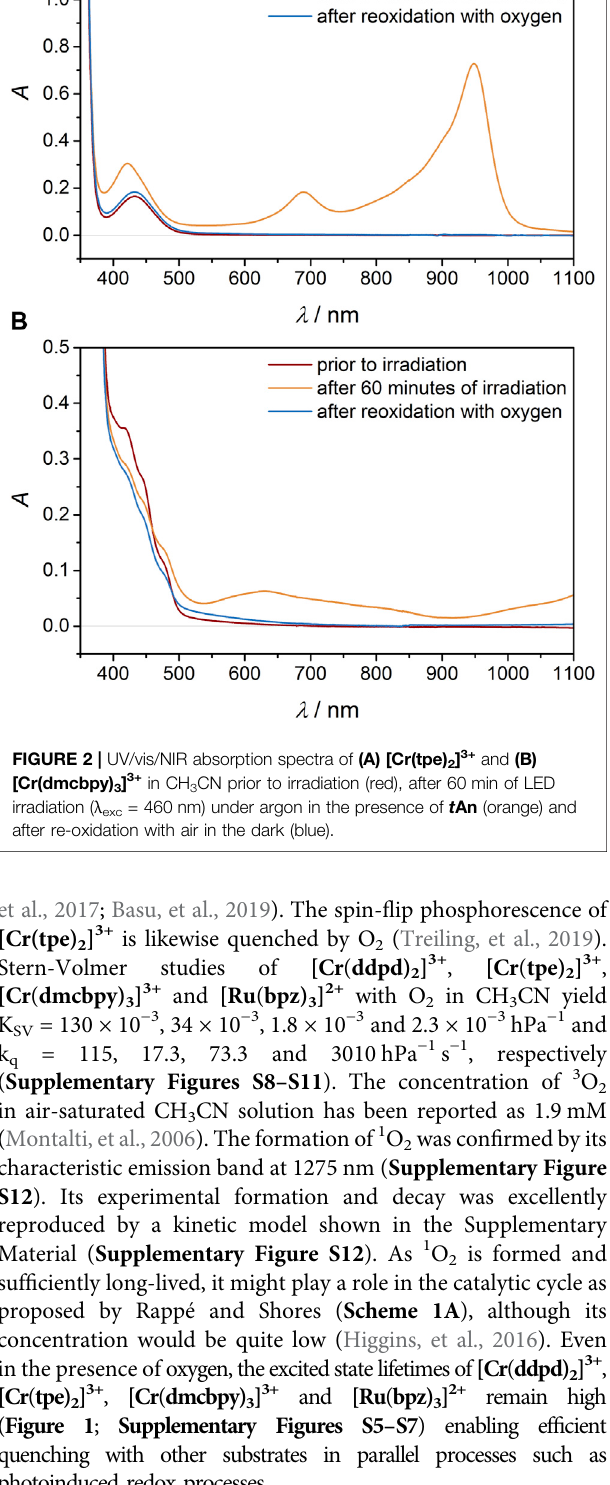
( Figure 1 ; Supplementary Figures S5 – S7 ) enabling ef fi cient quenching with other substrates in parallel processes such as photoinduced redox processes.